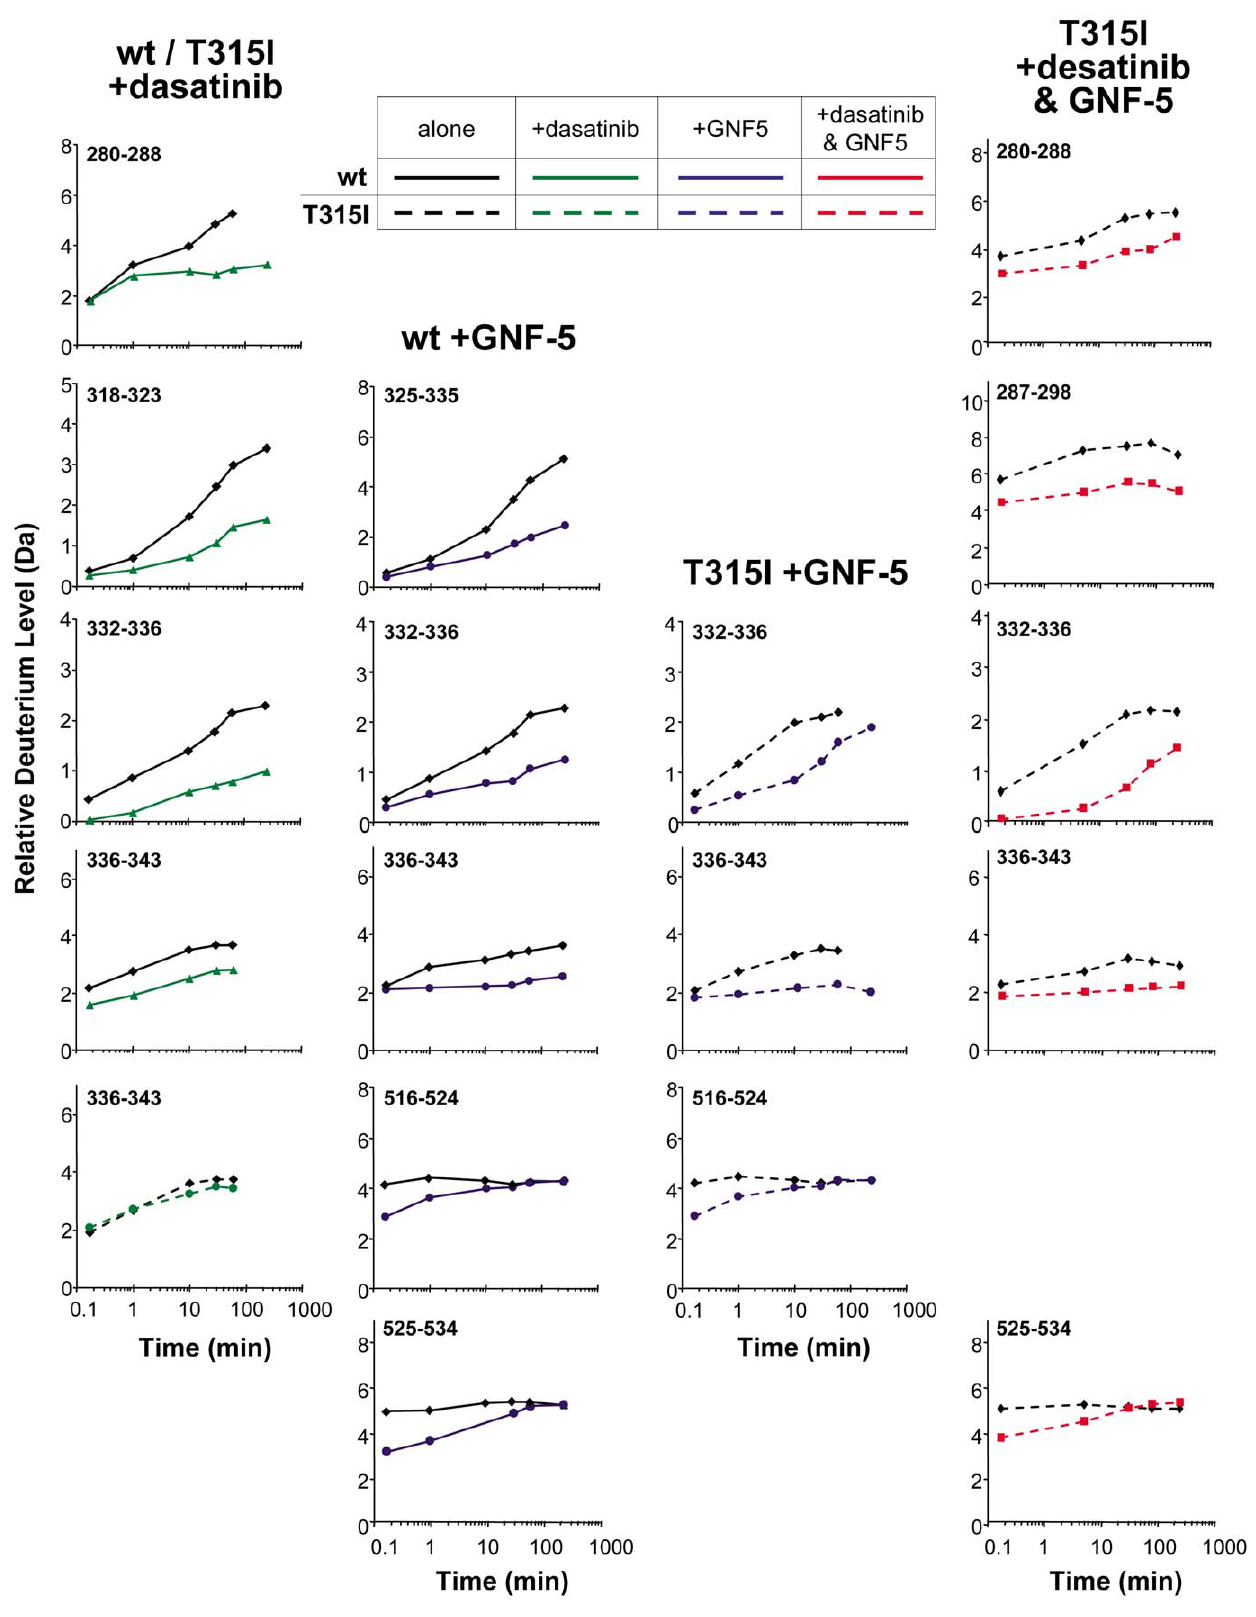
Figure 2. Deuterium incorporation curves for wild-type and T315I Abl in the presence of dasatinib, GNF-5 or both dasatinib and GNF-5. Both dasatinib and GNF-5 were present at a molar ratio of 1:7, protein:inhibitor. Only data for the peptides that showed changes in deuterium uptake in the presence of inhibitors are shown; all other regions indicated no changes in hydrogen exchange in the presence of the